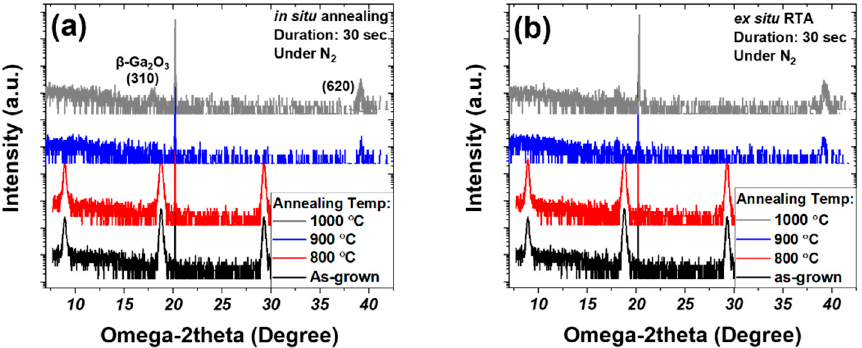
Figure 2. ( a ) XRD patterns taken from the samples subjected to varying in situ annealing temperature; ( b ) XRD patterns taken from the samples subjected to varying ex situ RTA temperature.